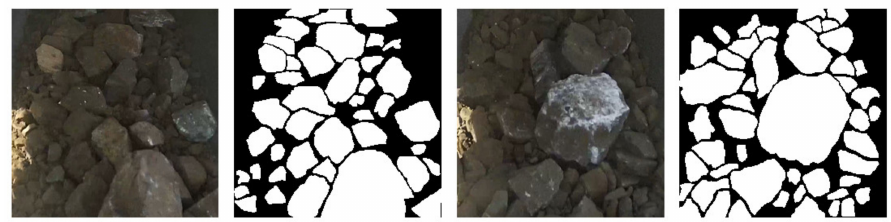
Figure 2. Examples of ore images and their